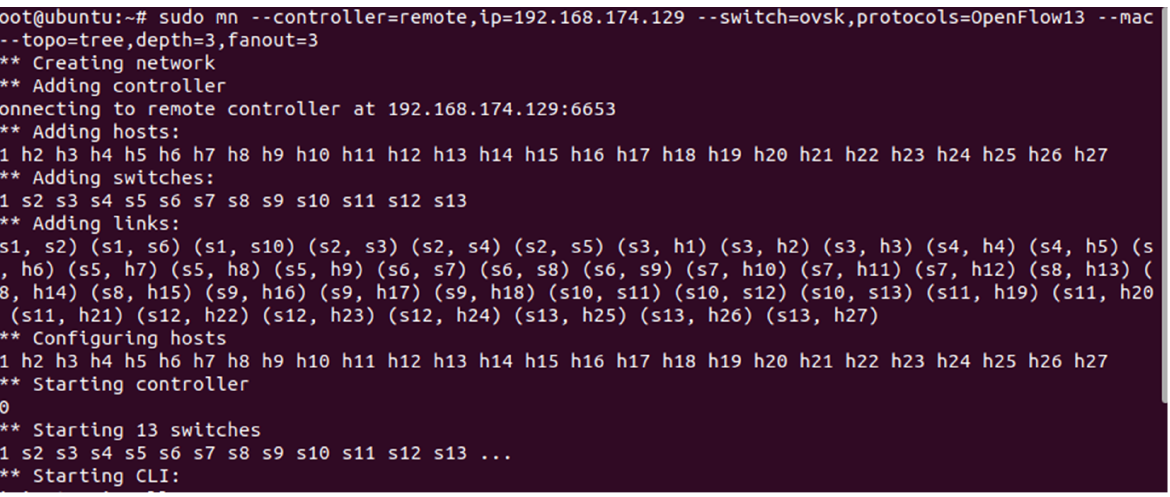
Figure 20. Custom simple topology.